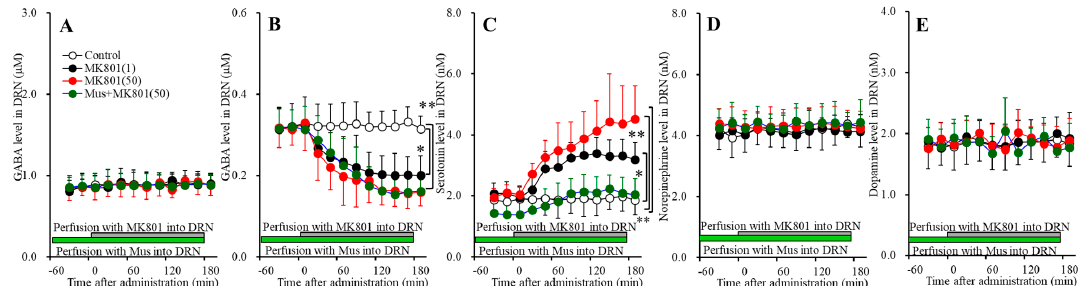
Figure 8. Concentration-dependent effects of local administration of MK801 (1 and 50 μ M) into the DRN on extracellular levels of L -glutamate ( A ), GABA ( B ), serotonin ( C ), norepinephrine ( D ) and dopamine ( E ) in the DRN (Study_4). Ordinates: mean ± SD ( n = 6) of extracellular transmitter levels ( μ M or nM); abscissa: time after MK801 administration (min). Green and gray bars indicate perfusion with muscimol and MK801 into the DRN, respectively. * p < 0.05, ** p < 0.01; relative to control or 50 μ M MK801 by MANOVA with Tukey’s post hoc test.